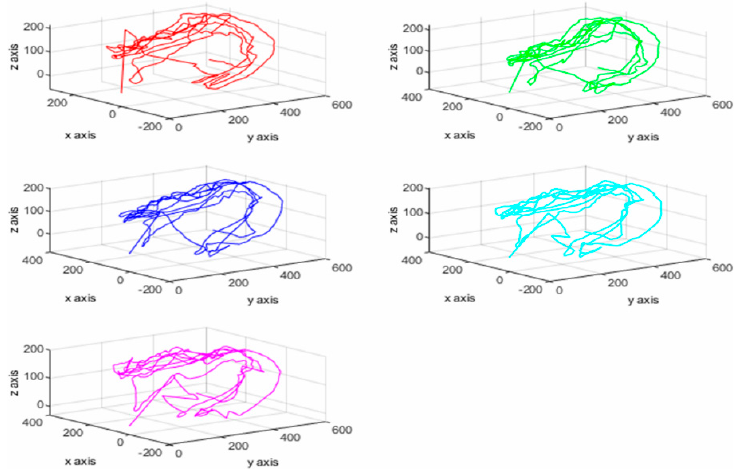
Figure 5. Tracking coordinates of the palm and fingers through the 3D graph. Red line: thumb (finger); green line: index; dark blue line: middle; sky blue line: ring; purple line: pinky. It is possible to analyze the upper extremity motor ability by tracking the movement of each finger of the user so that it can be presented as objective diagnostic evaluation data that conventional BBT cannot offer.